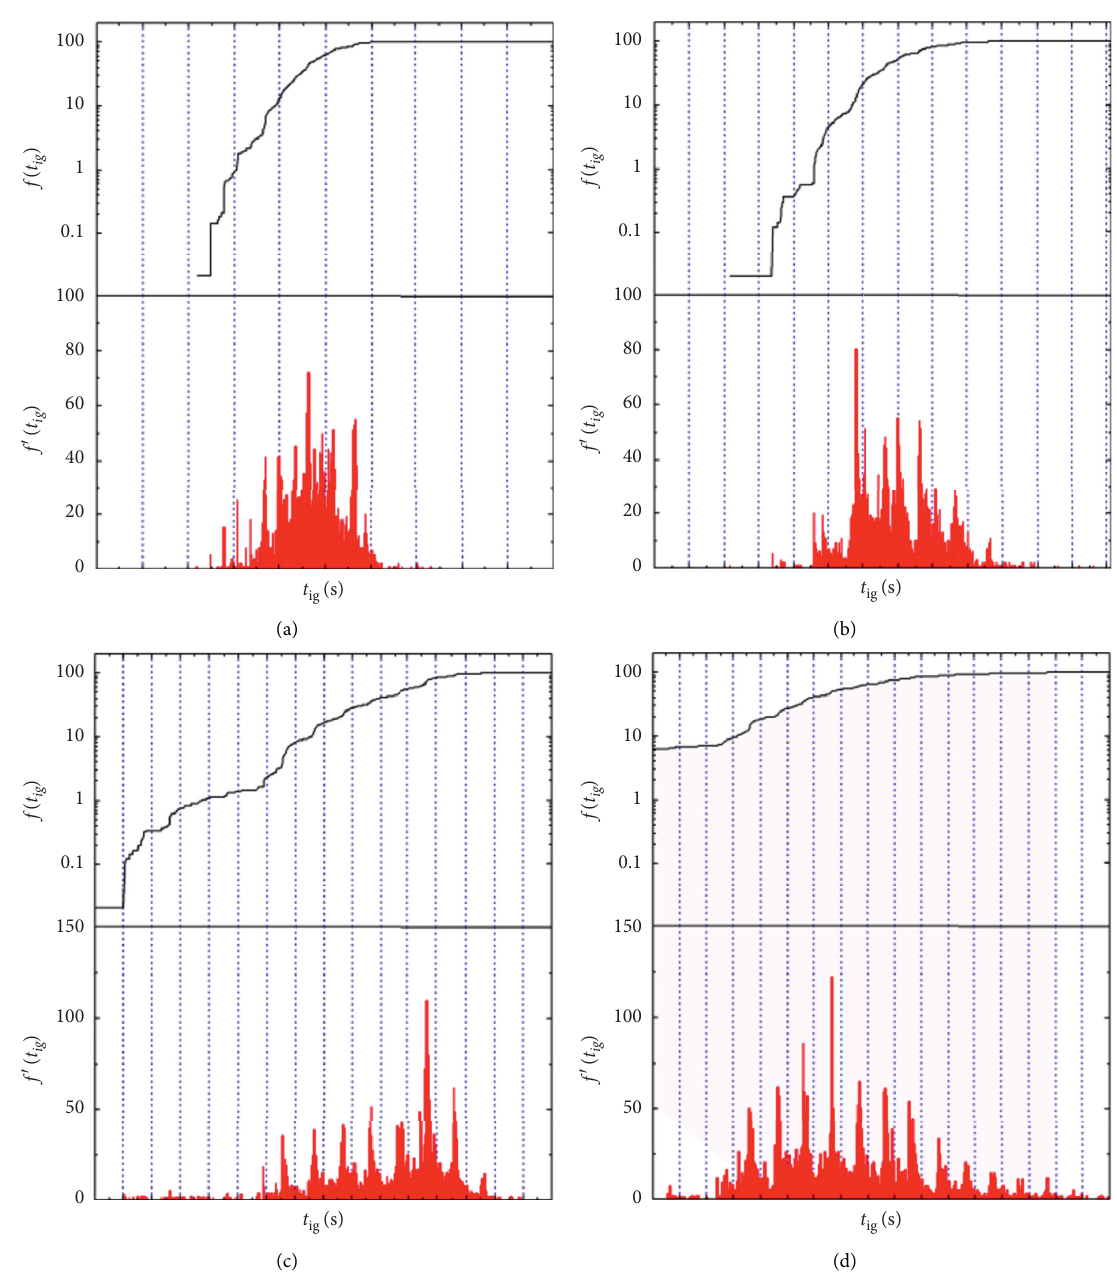
Figure 5: Cumulative distributions of ignition times (upper panel) and their first derivative (lower panel) over the whole set of powder particles for the fourth (a), sixth (b), tenth (c), and thirteenth (d) simulations described in Table 1. Vertical-dashed lines correspond to the inversion points of the reactor swing. The bin size varies from 3.5 × 10 − 4 to 1.4 × 10 − 3